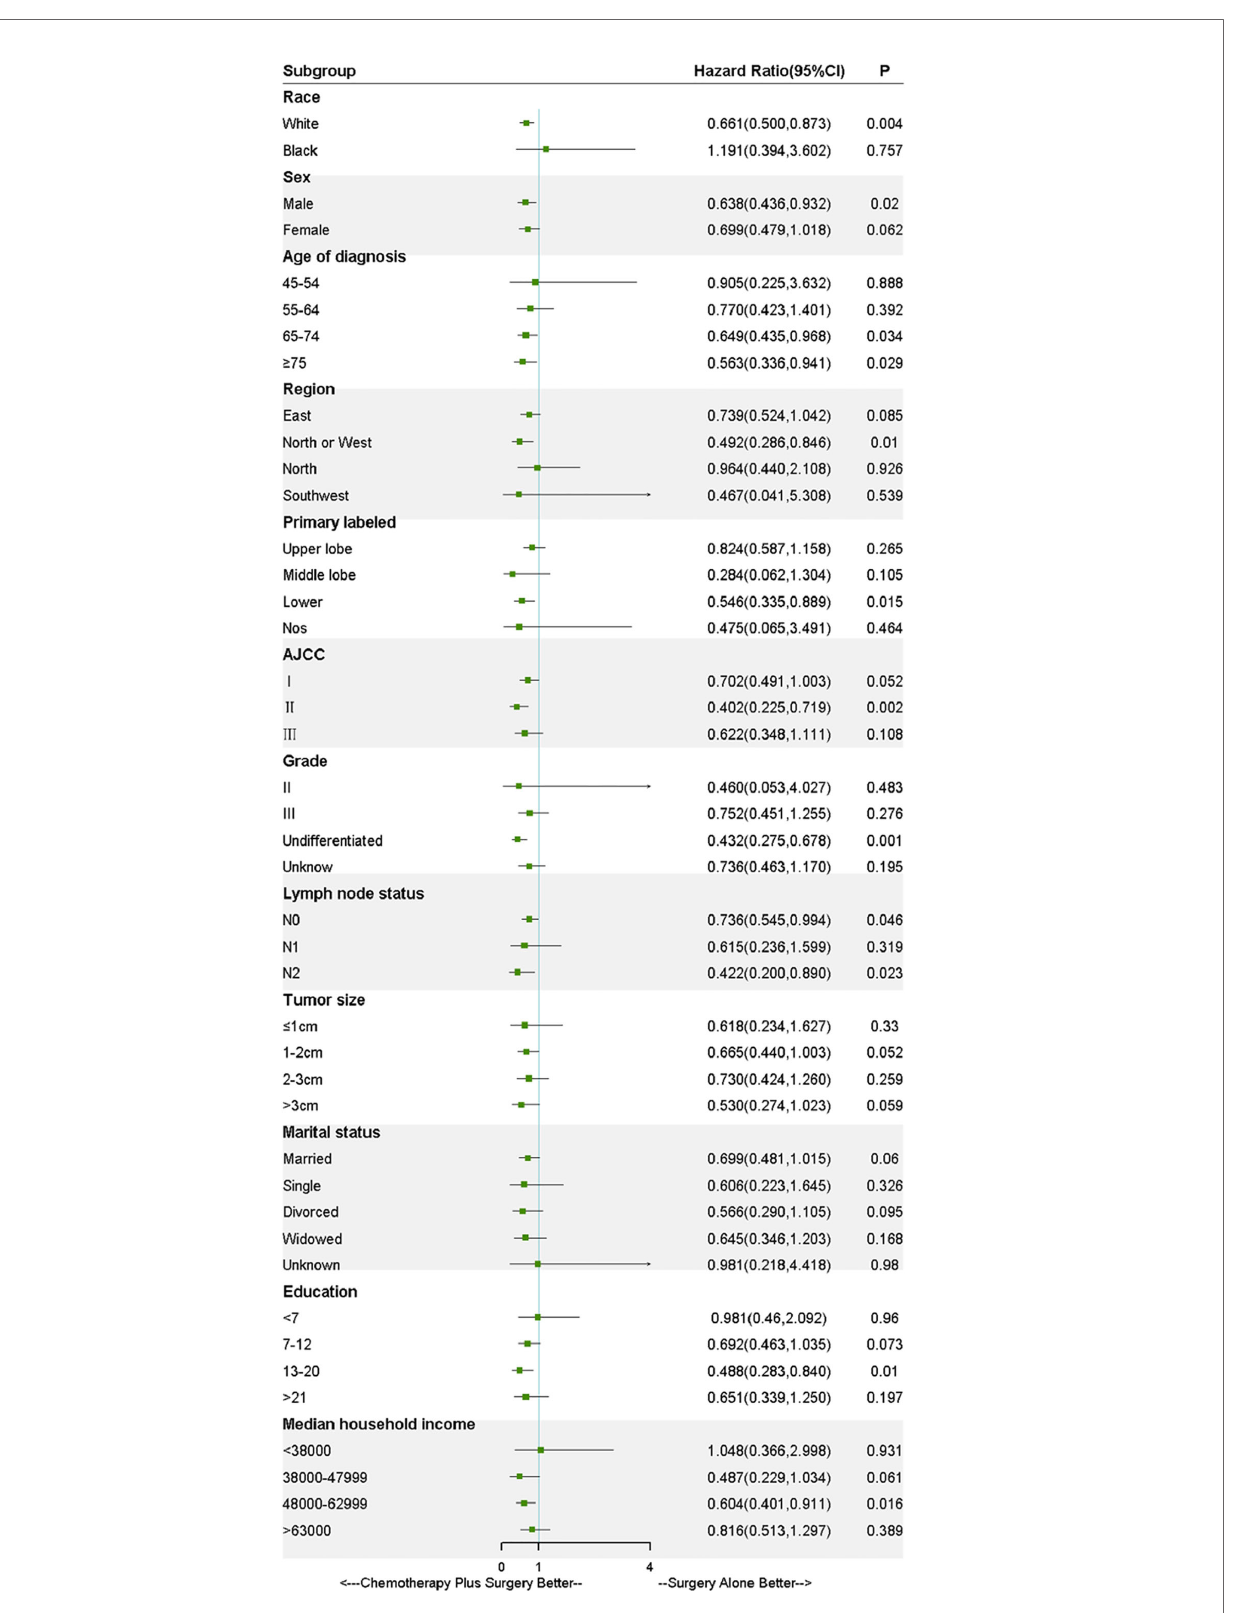
FIGURE 3 | Forest plot of the strati fi ed